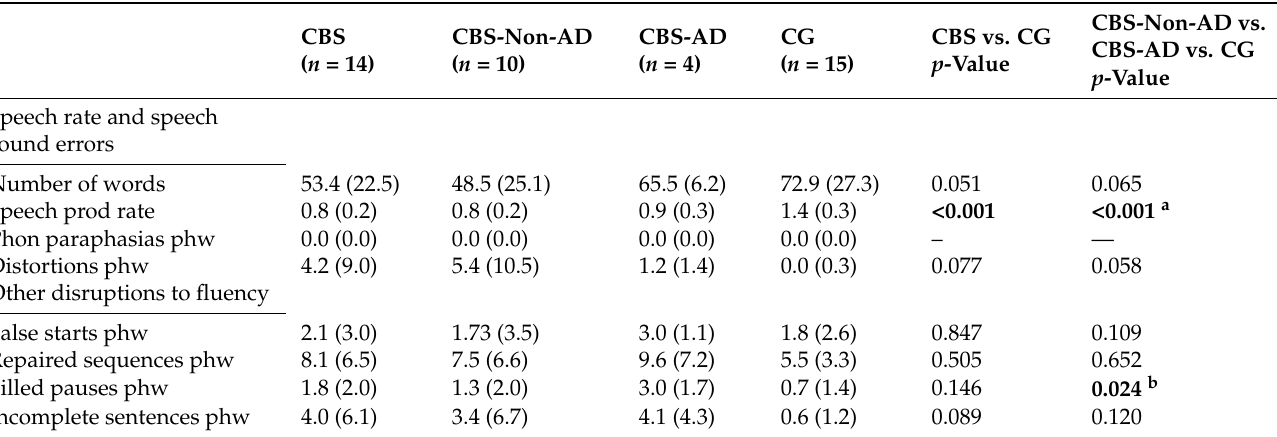
Table 4. Performance on discursive measures related to “speech rate and speech sound errors” and “other disruptions to fluency” by diagnostic